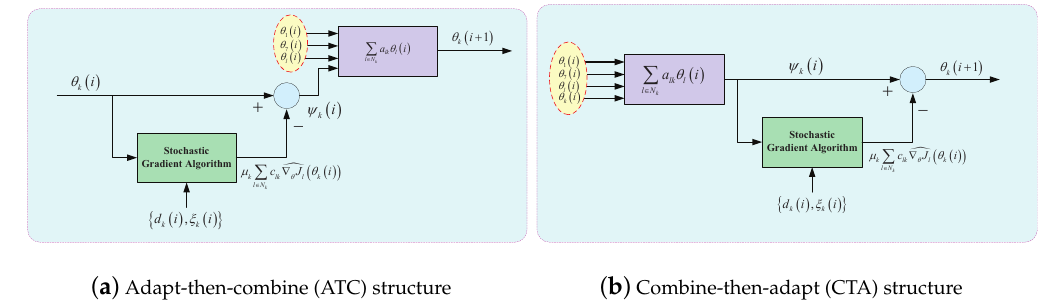
Figure 5. The two structures of diffusion